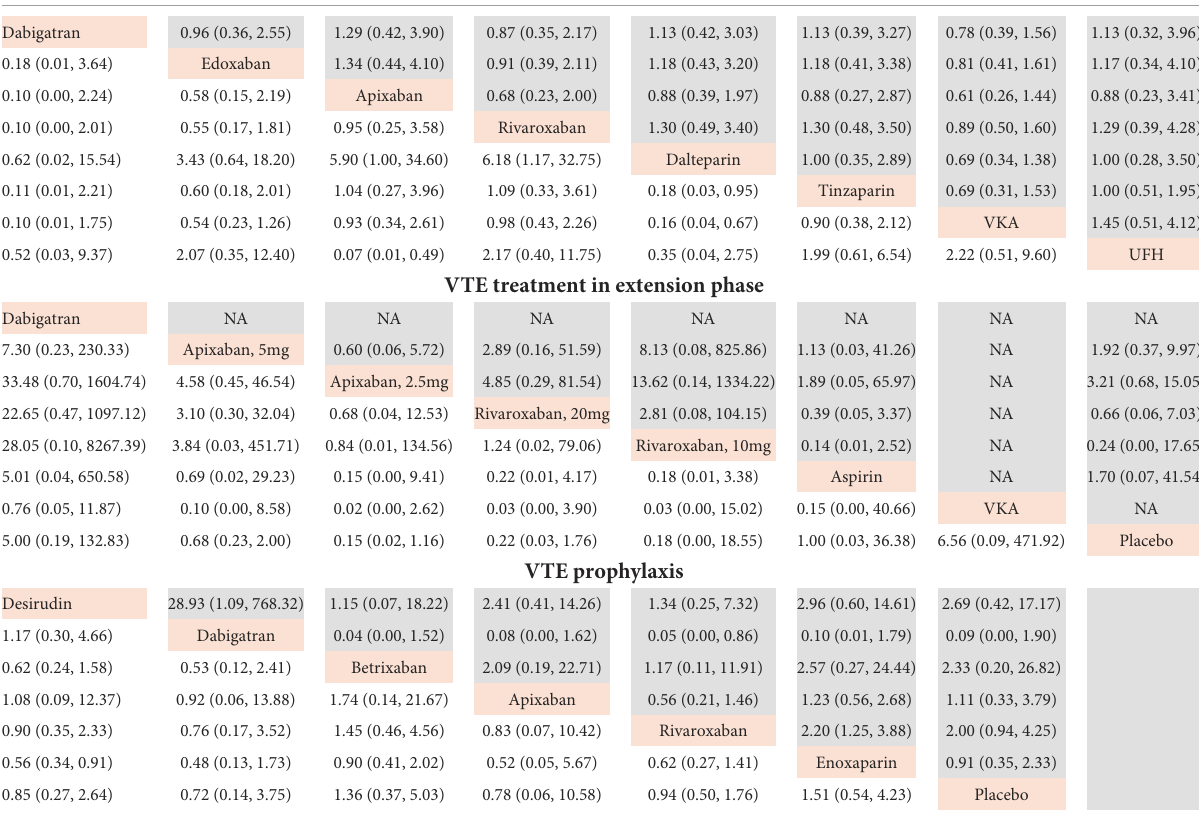
VTE treatment in acute phase